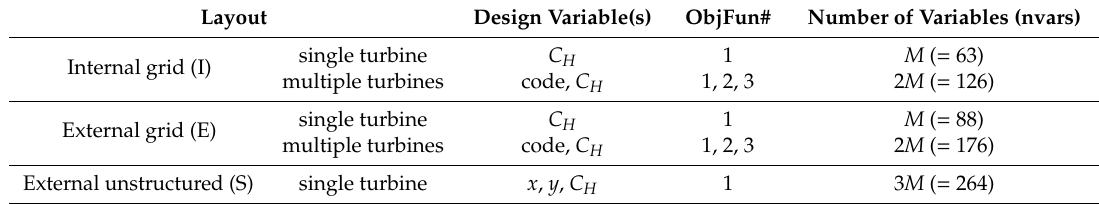
Table 3. The di ff erent cases considered in this paper. The objective functions are listed in Table